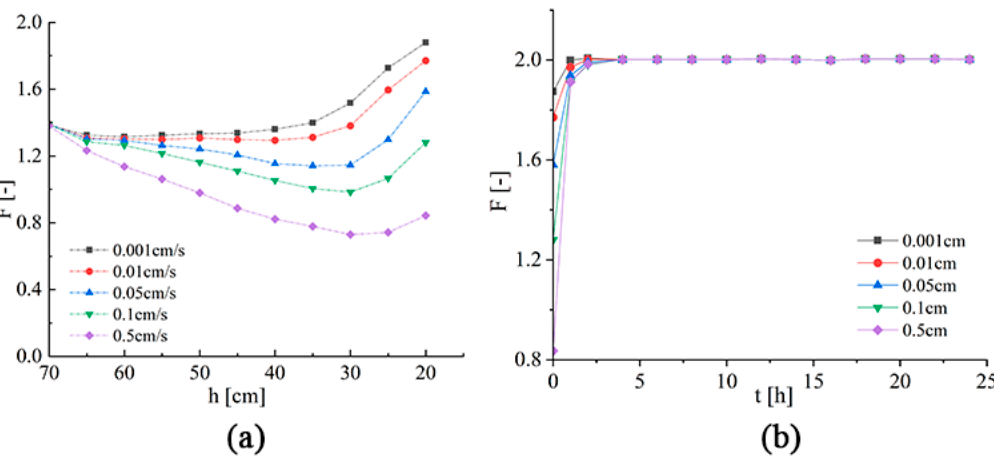
Figure 13. The safety factor of medium sand slope varies with different influence conditions under different water levels: ( a ) falling speed and ( b ) time.